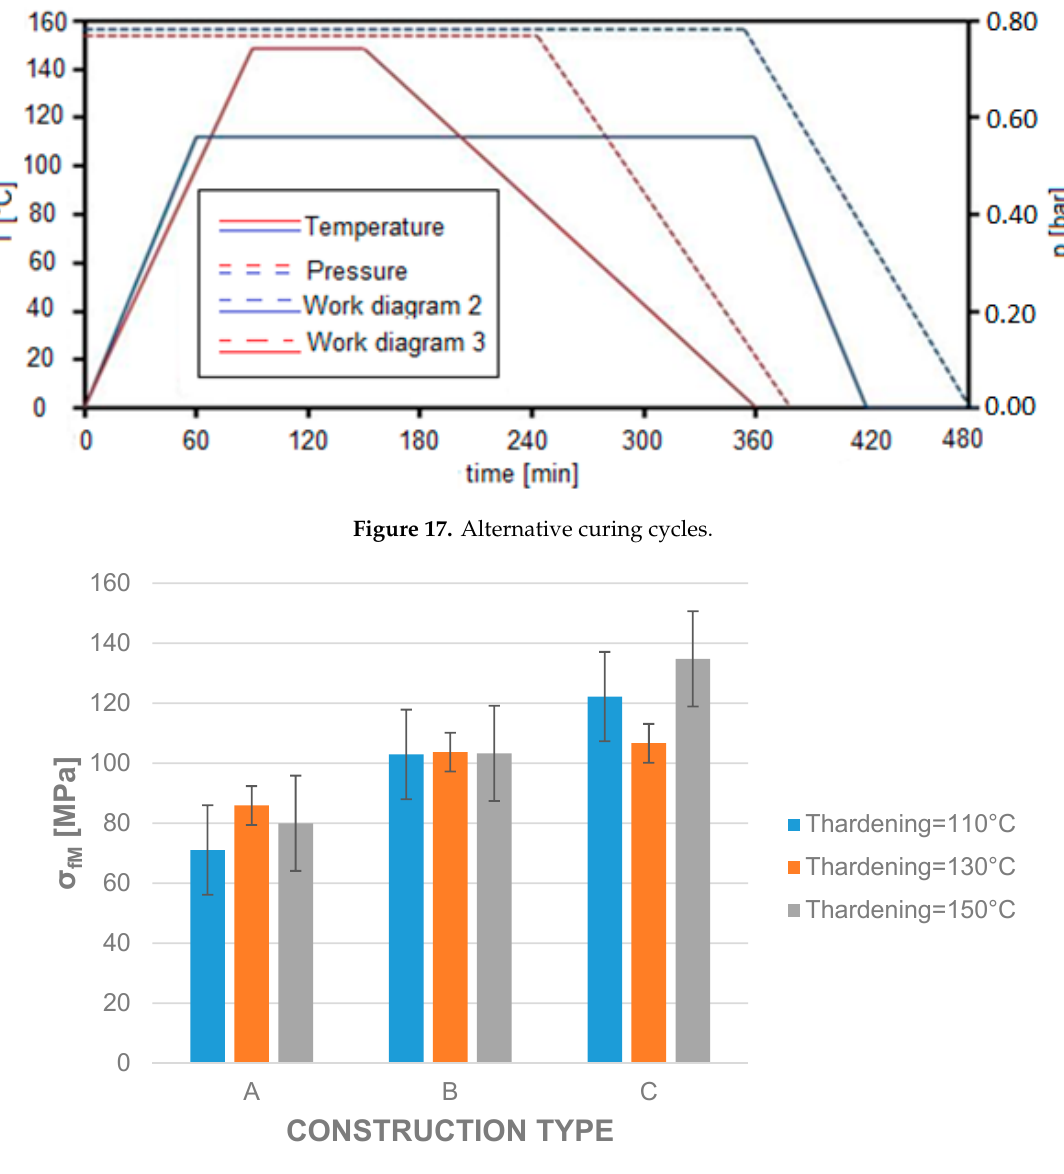
Figure 18. Influence of curing cycles on the bending strength of the A, B, and C constructions (used core: honeycomb C2-3.2-80/L orientation).